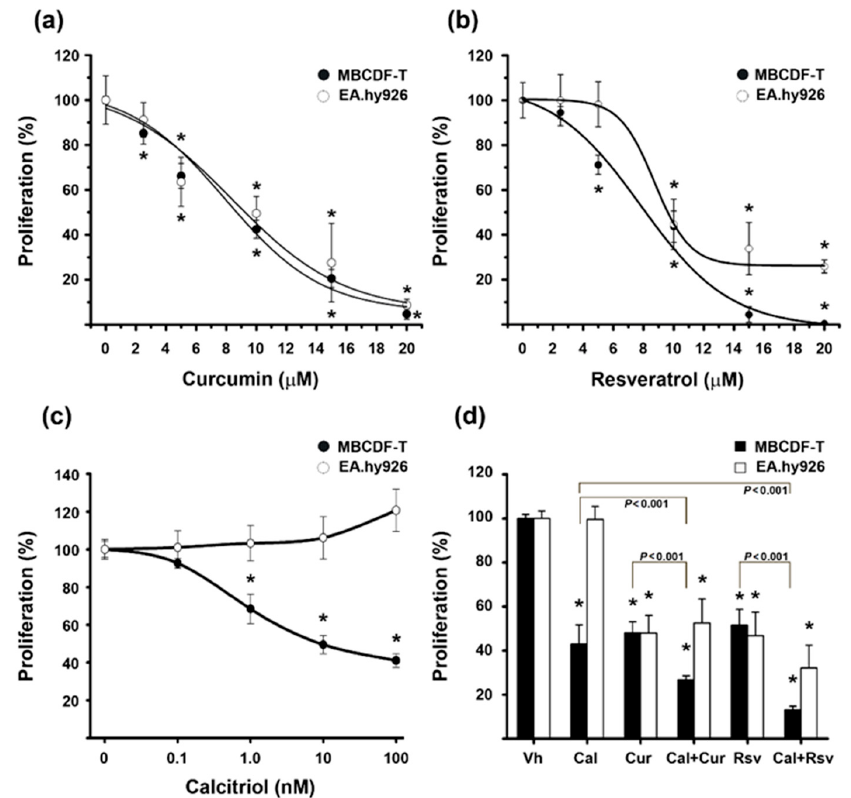
Figure 2. E ff ect of curcumin, resveratrol, and / or calcitriol in MBCDF-T and EA.hy926 cells proliferation. Dose-response curves of curcumin ( a ), resveratrol ( b ), and calcitriol ( c ) in MBCDF-T (black circles) and EA.hy926 cells (white circles). Medium containing vehicle (ethanol, 0.1%), calcitriol (0.1–100 nM), curcumin, or resveratrol (2.5–20 µ M) was added in sextuplicate and incubated for 6 days. Curcumin and resveratrol inhibited cell proliferation in a dose-dependent manner in both MBCDF-T cells and EA.hy926, while calcitriol only decreased the proliferation of the MBCDF-T cells. ( d ) Drug combinations study. Incubation of MBCDF-T (black bars) and EA.hy926 (white bars) were performed during 6 days in the absence or the presence of calcitriol (Cal, 10 nM), curcumin (Cur, 10 µ M), resveratrol (Rsv, 10 µ M), or the combination of calcitriol with curcumin (Cal + Cur) or with resveratrol (Cal + Rsv). Results are depicted as the mean ± SEM of sextuplicate determinations in at least three di ff erent experiments and were normalized vs. control or vehicle (Vh) values, which were set to 100%. * p < 0.001 vs. control. In panel ( d ), lines depict the significance between co-treatments and monotherapy ( p < 0.001). For the cell line MBCDF-T, * p < 0.001 vs. vehicle and for the cell line EA.hy926 * p ≤ 0.002 vs. both Vh- and Cal-treated